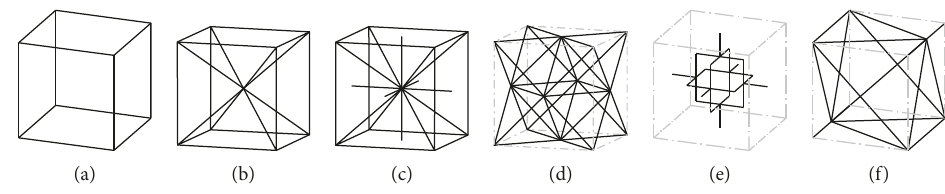
Figure 4: Cell types: (a) SC [22], (b) BCC [22], (c) RBCC [22], (d) OT [23], (e) GA [25], and (f) WG